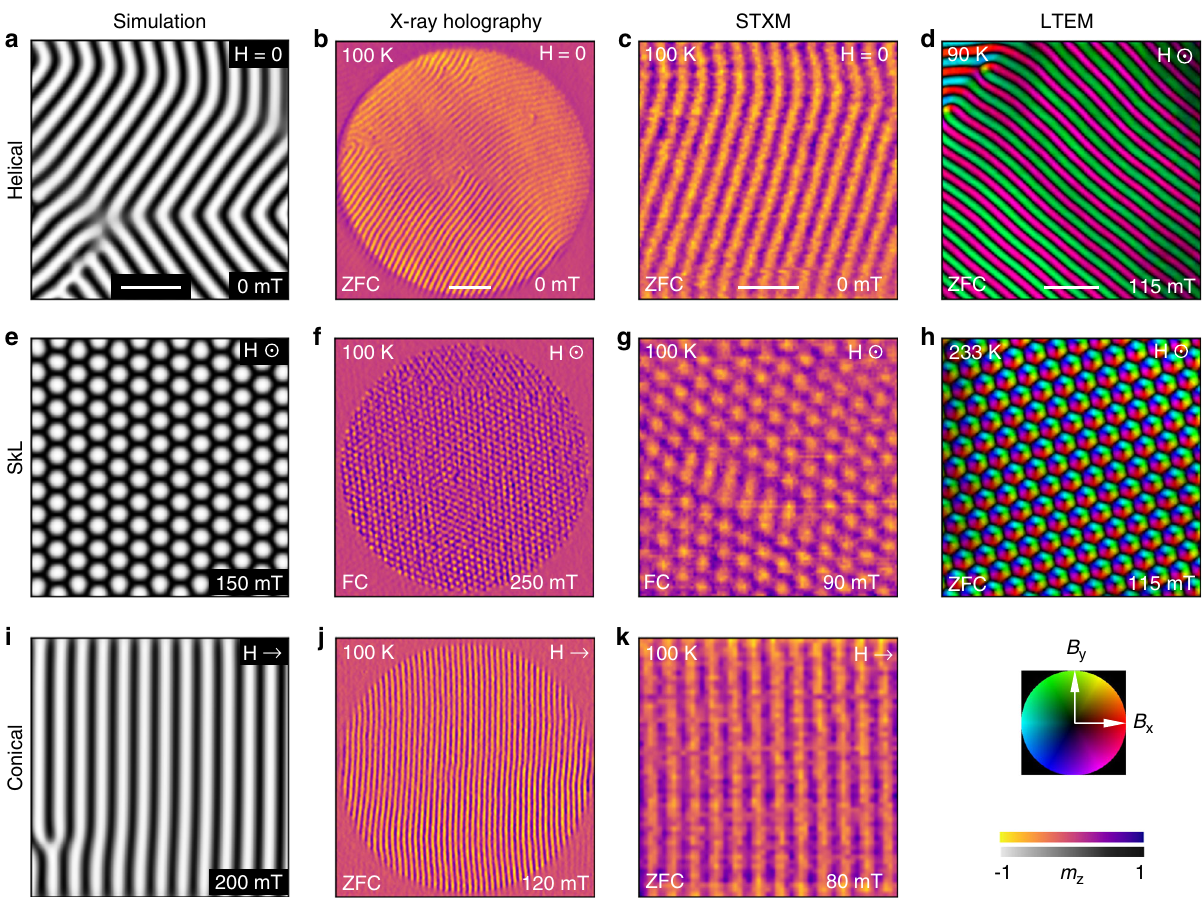
Fig. 3 Real-space imaging of chiral spin textures. Micromagnetic simulations, experimental X-ray holography images, STXM images and LTEM images of the a – d helical, e – h SkL and i – k conical magnetic spin textures. The simulation, X-ray holography and STXM images plot the normalised out-of-plane magnetisation, m z , as the colourmap, while the LTEM images plot the in-plane magnetic fl ux density as the colourmap, with the direction indicated by the colour wheel at the bottom right. Scale bar in b , 500 nm. All other scale bars, 200